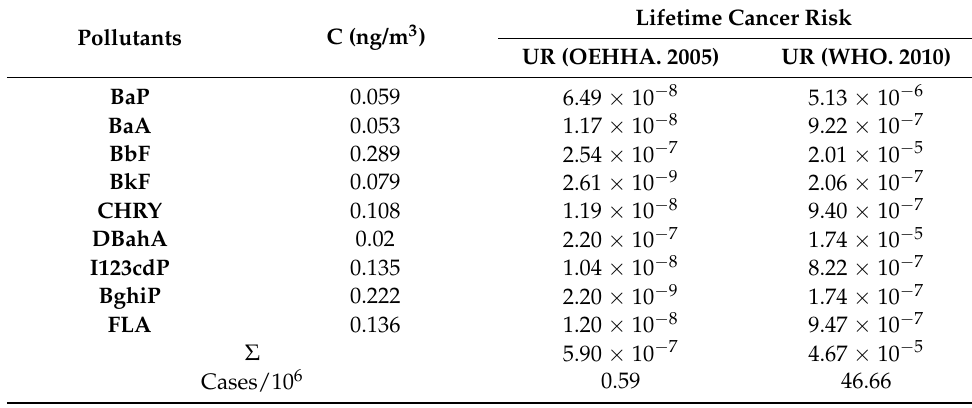
Table A4. Cancer risk assessment A.IV method (Gao, 2019).